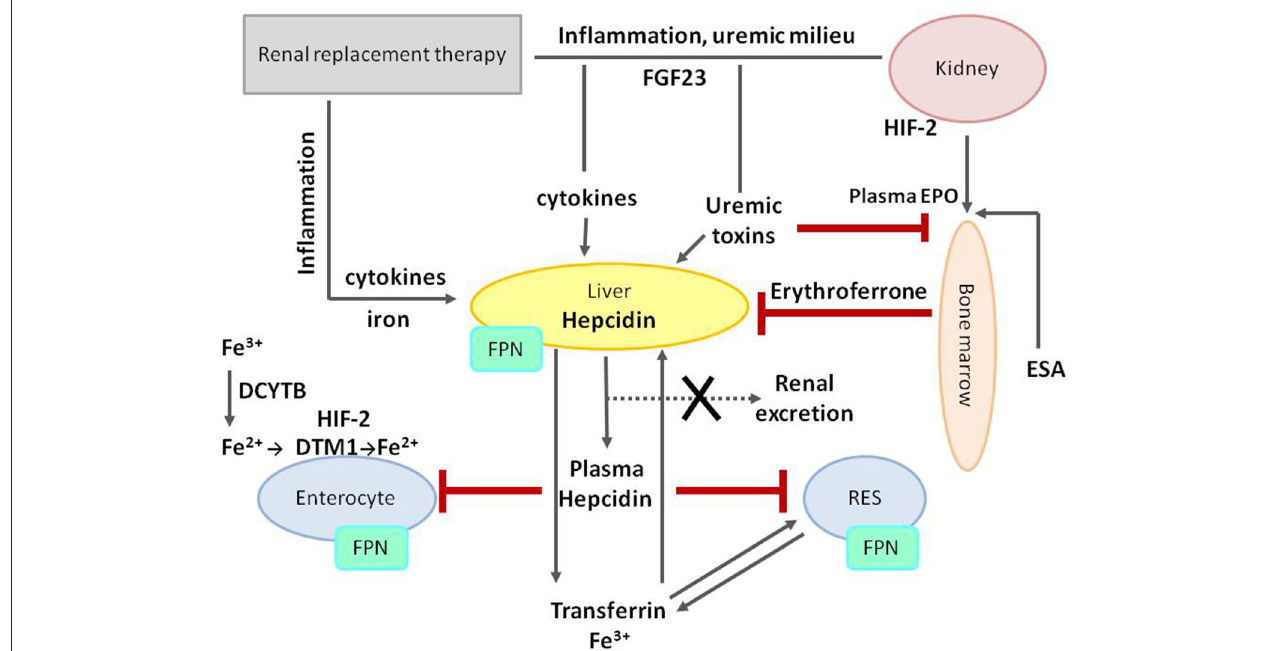
FIGURE 6 | Iron metabolism dysregulation in chronic kidney disease. The central role in iron metabolism regulation plays an increased level of hepcidin, decreasing FPN on cell membranes and thus diminishing duodenal iron absorption and acquirement from stores in RES. Hepcidin expression and production are stimulated by iron treatment, inflammation, uremic milieu, and fibroblast growth factor 23 (FGF23), and, at the same time, its removal is impaired due to decreased glomerular filtration rate (GFR). Both erythropoietin and erythroferrone play suppressive effect on hepcidin production. FPN, ferroportin; RES, reticuloendothelial system; HIF-2, hypoxia-inducible factor 2; DCYTB, duodenal cytochrome B reductase; DTM1, divalent metal transporter 1; FGF23, fibroblast growth factor 23; EPO, erythropoietin; ESA, erythropoiesis-stimulating